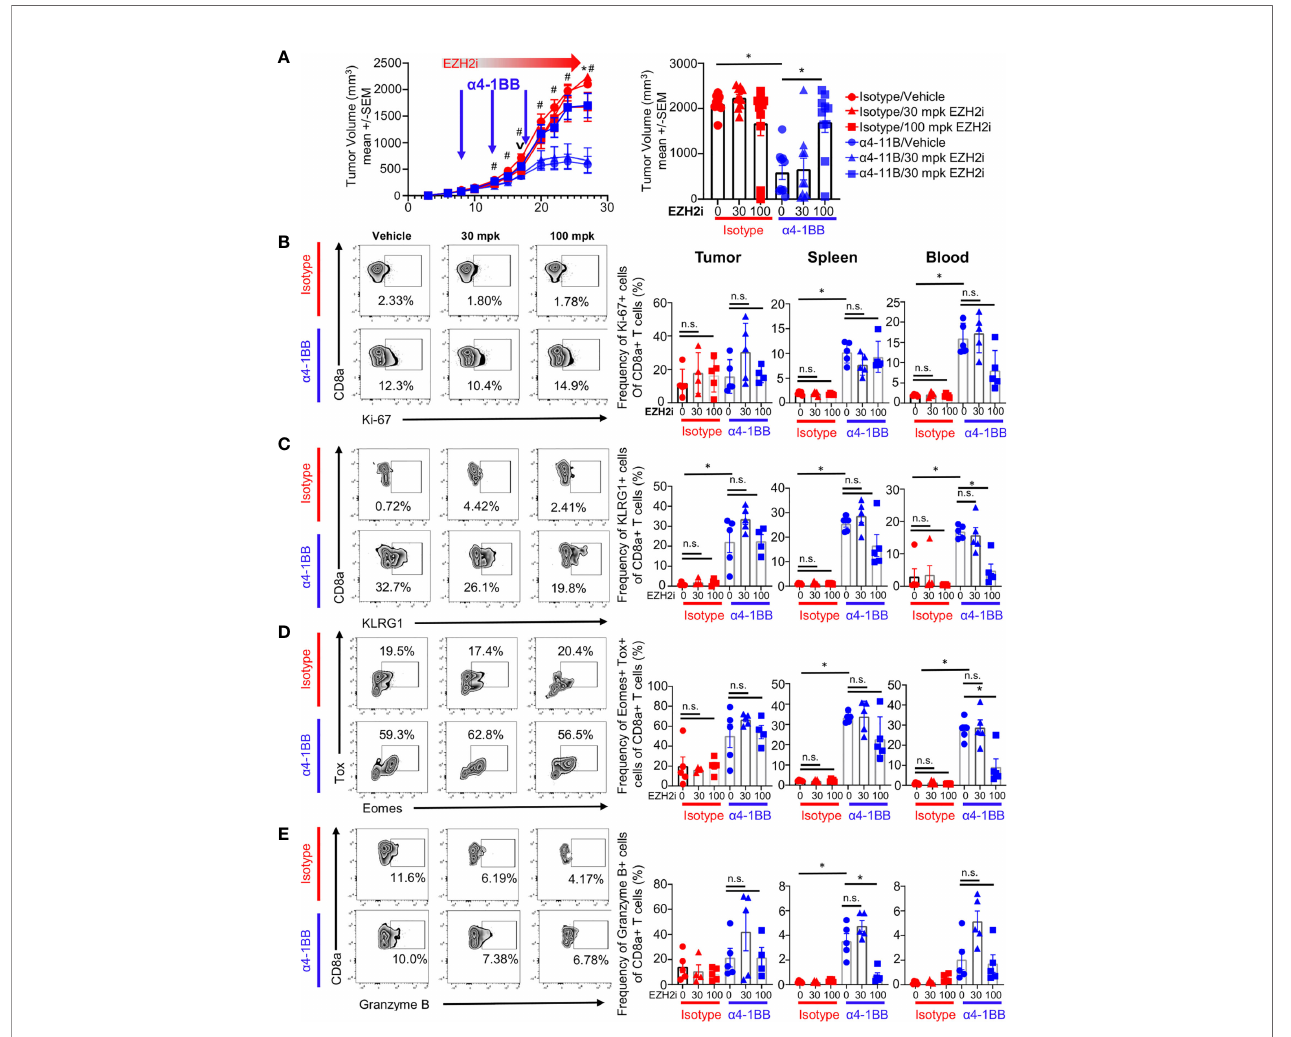
FIGURE 1 | EZH2i compromise a 4-1BB ef fi cacy. CT26-tumor bearing mice were treated daily with a single s.c. injection of EZH2 inhibitor starting on day 6 post implantation and then treated with a 4-1BB starting on day 8, every 5 days for a total of three doses. Tumor growth curves ( A , left panel) and fi nal tumor volumes ( A , right panel) are shown for treatment groups. Mice harvested at day 17 (v) for T cell phenotypes were analyzed by fl ow cytometry. Representative FACs plots from tumor samples ( B – E , left panel) and pooled data dot plots from tumor, spleen, and blood ( B – E , right panel) are shown for proliferating CD8 + T cells (B) , activated effectors (C, D) , and cytotoxic cells (E) . Mice treated with isotype are marked in red; mice treated with a 4-1BB are marked in blue. Vehicle treated control mice are marked with circles; triangles indicate 30 mpk EZH2i treatment while squares indicated 100 mpk EZH2i treatment. For A, asterisks (*) indicate p<0.05 as determined by ANCOVA for comparison of groups treated with a 4-1BB with and without 100 mpk dosing with EZH2i while hashtags (#) indicate p<0.05 for comparison of groups treated with vehicle control with and without a 4-1BB. For B-E, Asterisks (*) indicate p<0.05 as determined by 2way ANOVA and post hoc comparison of group means. n.s. indicates non-signi fi cant result. n ≥ 9 mice per group for tumor growth inhibition studies (A) . n ≥ 4 mice per group for T cell analysis (B – E)